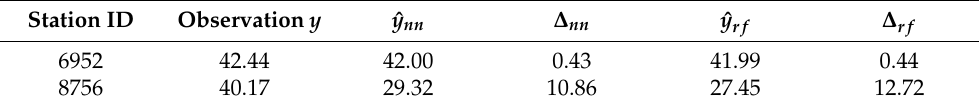
Table 1. Example stations with the station IDs to identify them in the Tropospheric Ozone Assessment Report database. Station 6952 is located in Spain, while Station 8756 is situated in Greece. The subscripts point to the corresponding model abbreviation, nn for the neural network and rf for the random